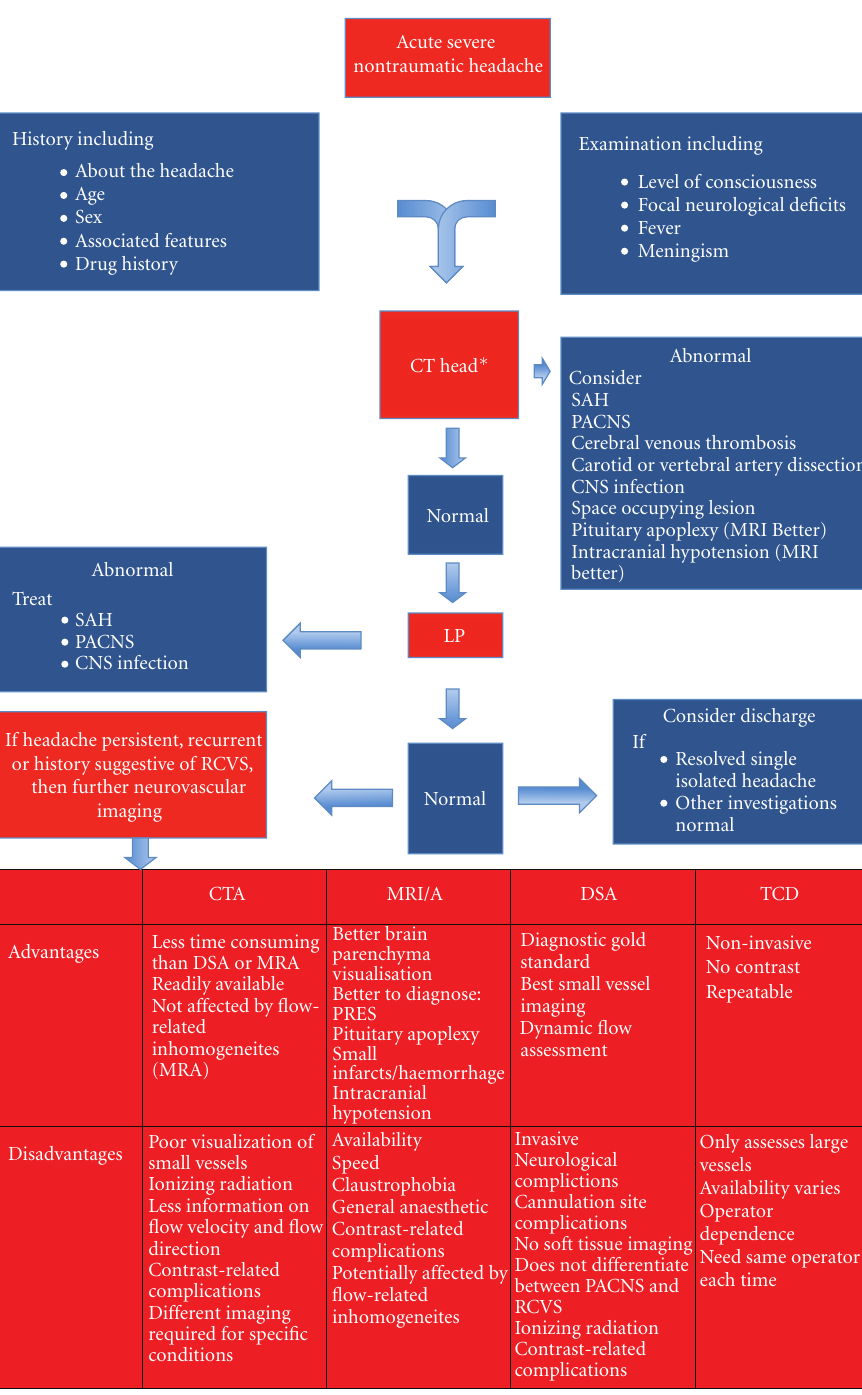
Cervical artery dopplers have been used to investigate for arterial dissection in the context of acute severe headache; whilst having a significantly favourable complication profile compared to any form of angiogram, there are bony regions limiting ultrasound imaging, greatly reducing the sensitivity of this